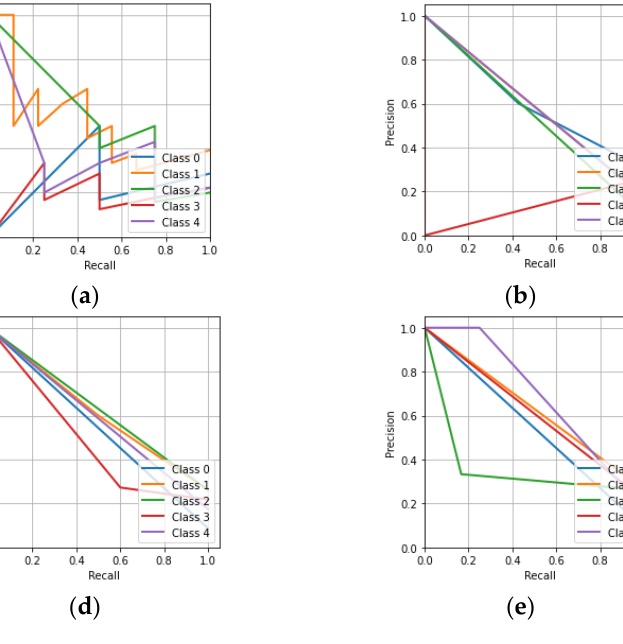
Figure 14. Precision-recall characteristic for the whole information dataset: ( a ) CNN; ( b )